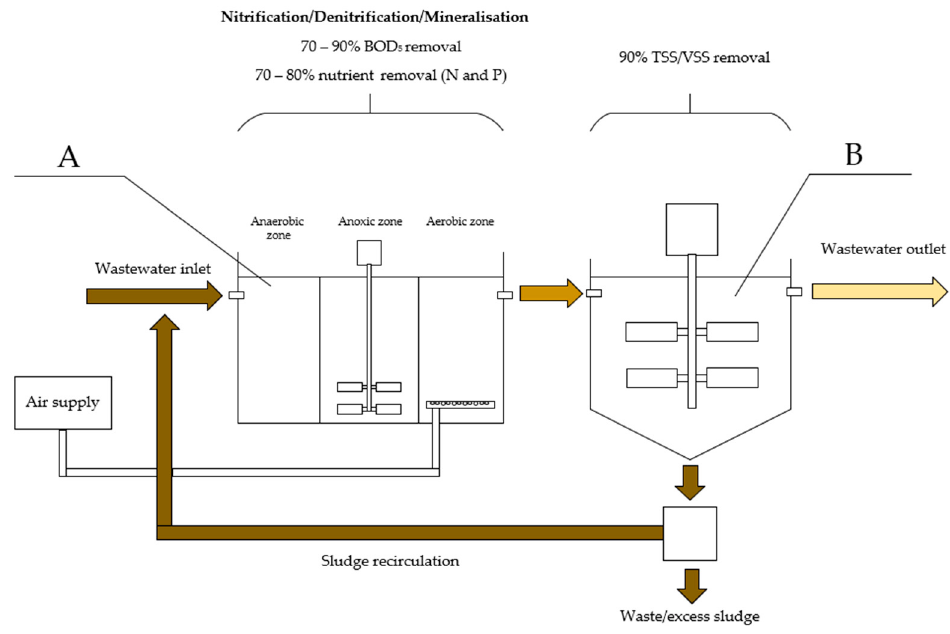
Figure 8. Conventional AS process scheme, based on [65]; where: A—reaction/aeration tank; B—secondary clarifier. Table 3. Comparison of the physico-chemical properties of biogranules with AS flocks [23].